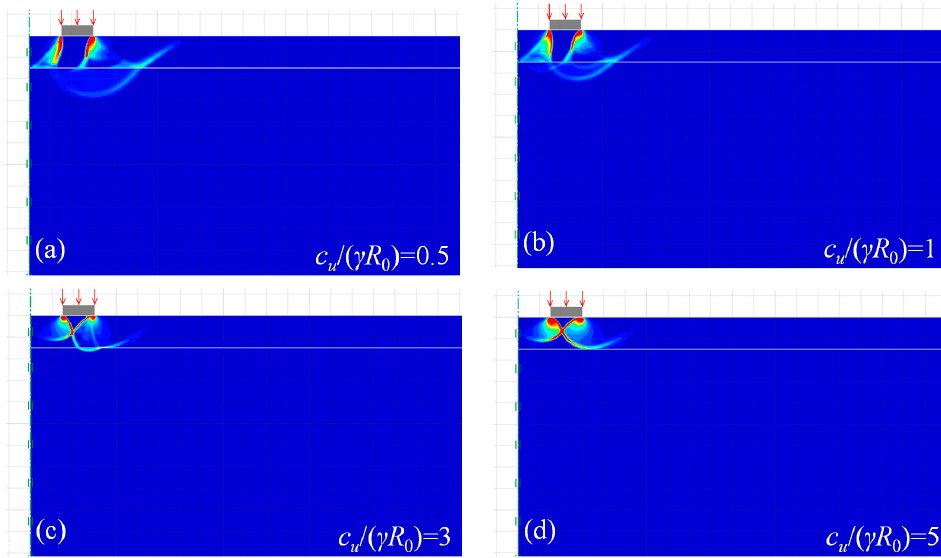
Figure 8. Upper bound collapse mechanisms for R i / R 0 =0.5, φ =35°, and H / R 0 =0.5 with (a) c u /( γ R 0 )=0.5, (b) c u /( γ R 0 )=1, (c) c u /( γ R 0 )=3, and (d) c u /( γ R 0 )=5.